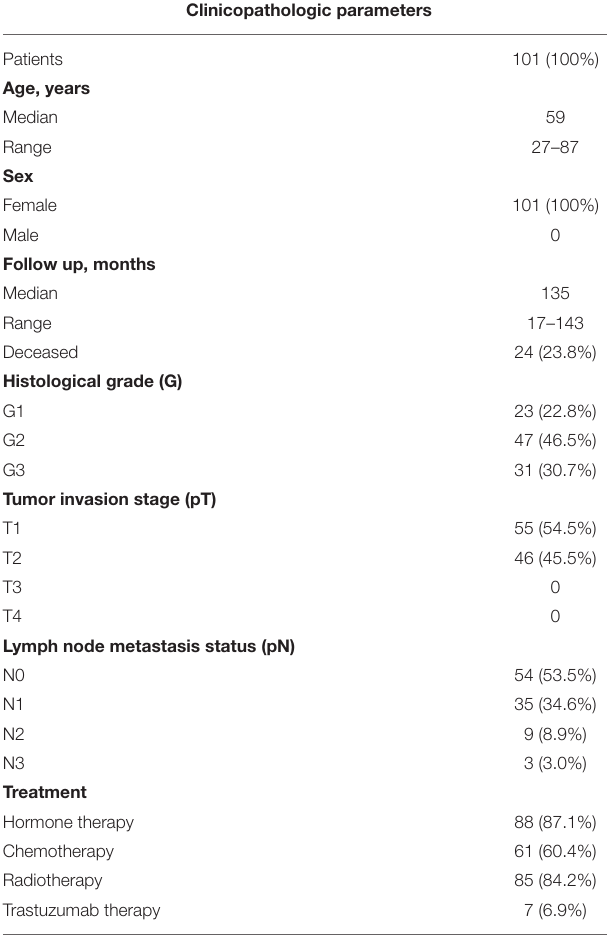
TABLE 1 | Patient and tumor clinicopathologic